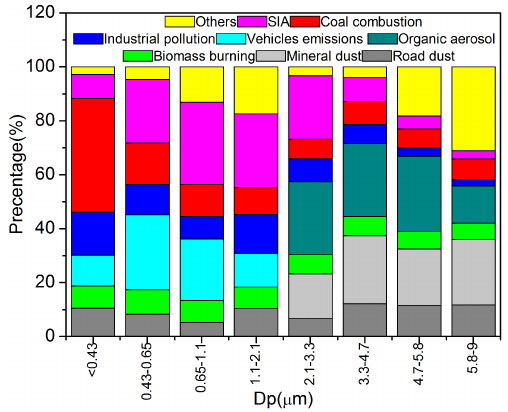
Figure 7. Relative contributions from each identified source to dif- ferent size